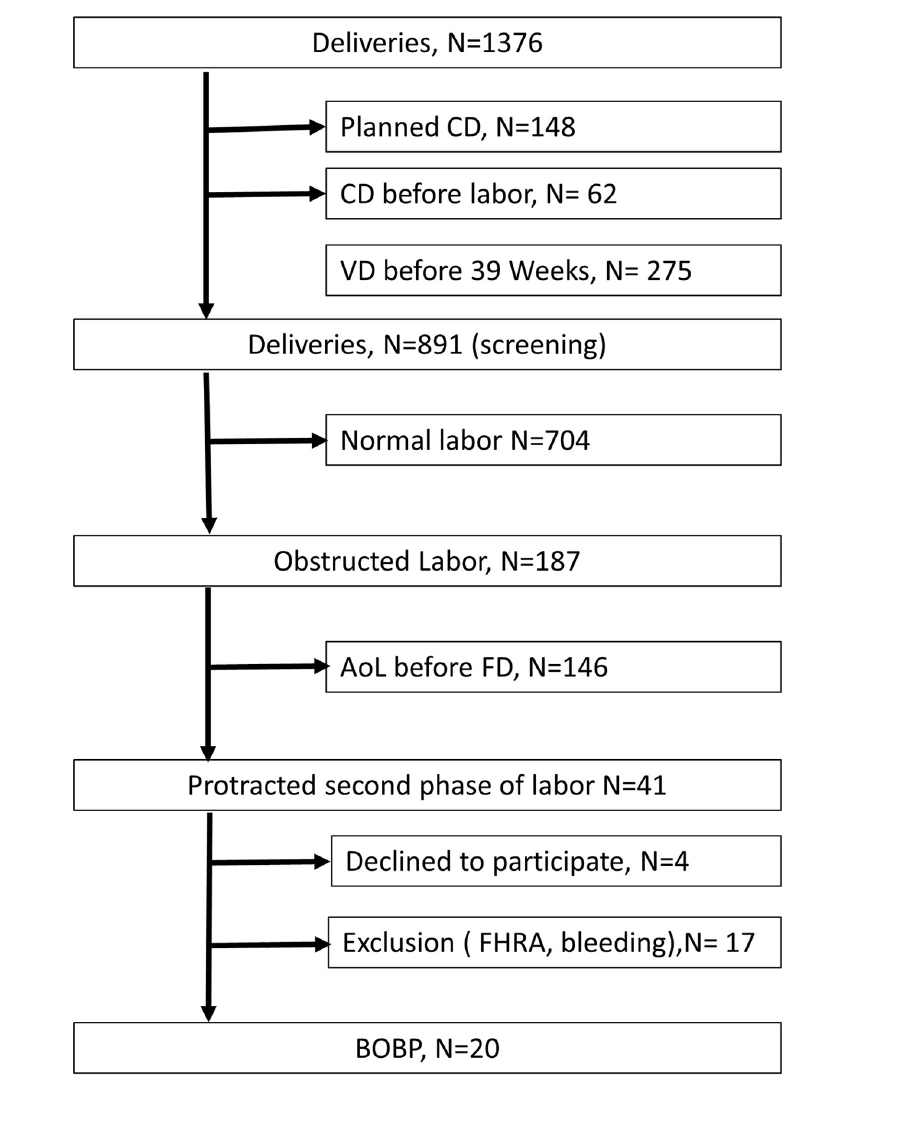
Fig 1. Illustration of the biomechanically-optimized supine position assessed in this